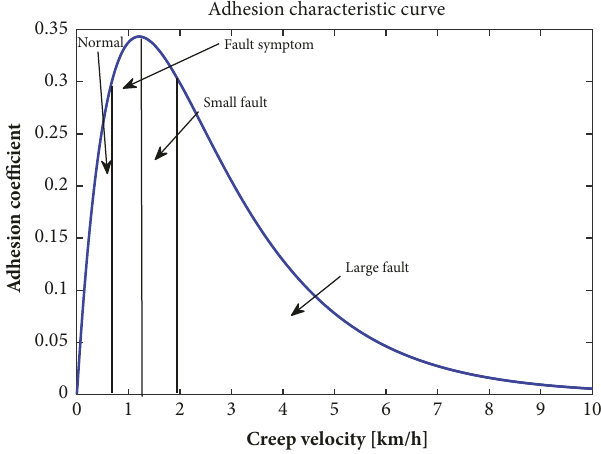
Figure 2: Refined adhesion characteristic